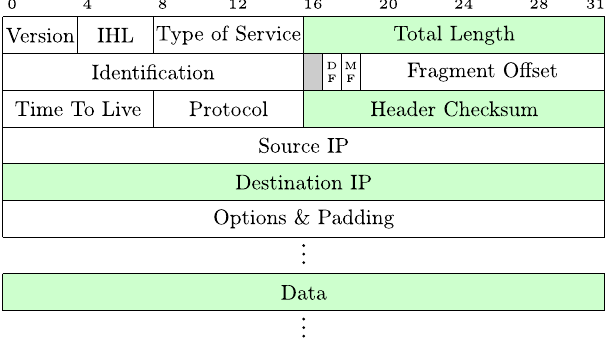
FIG. 6. IP header. All fields causing dependencies for the packet header of the reply are marked in green.